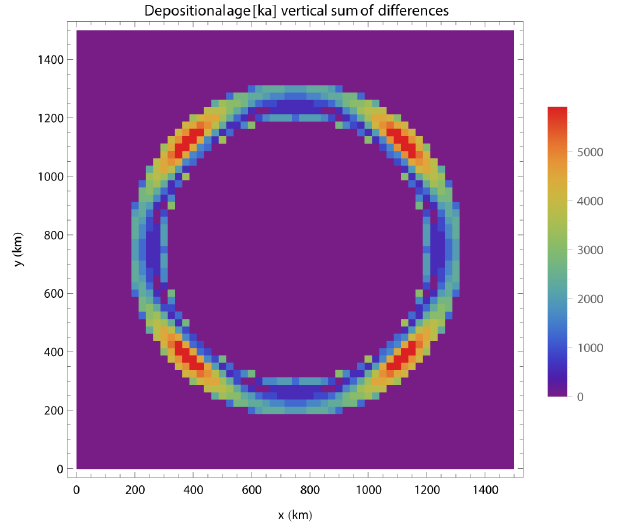
Figure 13. Difference of calculated age between first-order and de Almeida et al. (2009) backtracking with the EIS- MINT experiment A with flat topography. The colours indi- cate the vertical sum over all layers in the semi-Lagrangian grid of the absolute value of the differences at each grid cell: (cid:12) (cid:12) P ks max first order (ks) − de Almeida et al. (ks) (cid:12) (cid:12) (cid:12) (cid:12) . ks = 1 first order (ks)